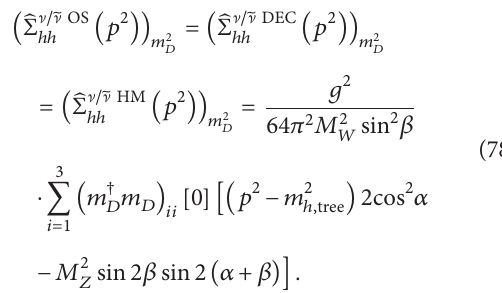
Figure 2: Comparison among the various schemes. (a) The renormalized self-energies evaluated at 𝑝 2 = 𝑚 2 ℎ, = 10 12 GeV, 𝑚 = 0 . 01 eV, and 𝑚 ̃𝐿 = ( 700 , 900 , 1000 ) GeV. (b) The predictions of the mass differences as functions of 𝑀 𝐴 , for 𝑚 𝑀 ] 1 1 , 2 , 3 1 , 2 , 3 Δ 𝑥 = Δ𝑀 𝑥 − Δ𝑀 mDR 𝑥 = DR (dashed lines) and OS and DEC (solid lines), as functions of 𝜇 ℎ ℎ , for ,𝑚 ,𝑚 ) (GeV): ( 10 14 , 10 14 , 10 14 ) (in light blue); ( 10 12 , 10 13 , 10 14 ) (in purple), and ( 10 13 , 10 14 , 10 15 ) (in green). The rest of masses, (𝑚 𝑀 𝑀 2 𝑀 3 1 input parameters are fixed as in (79). Δ𝑀 ℎ is defined in